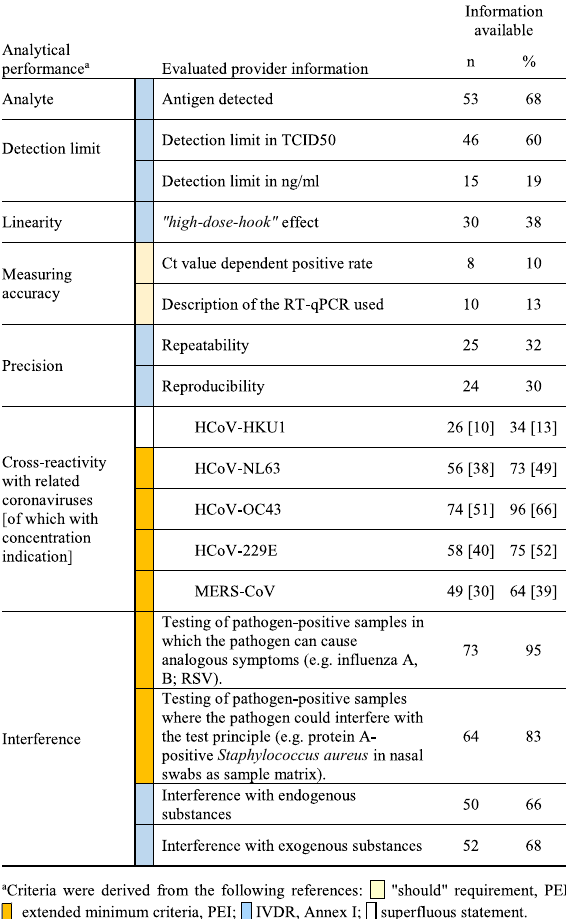
Table  : Availability of information on analytical performance characteristics in the test provider ’ s instructions for